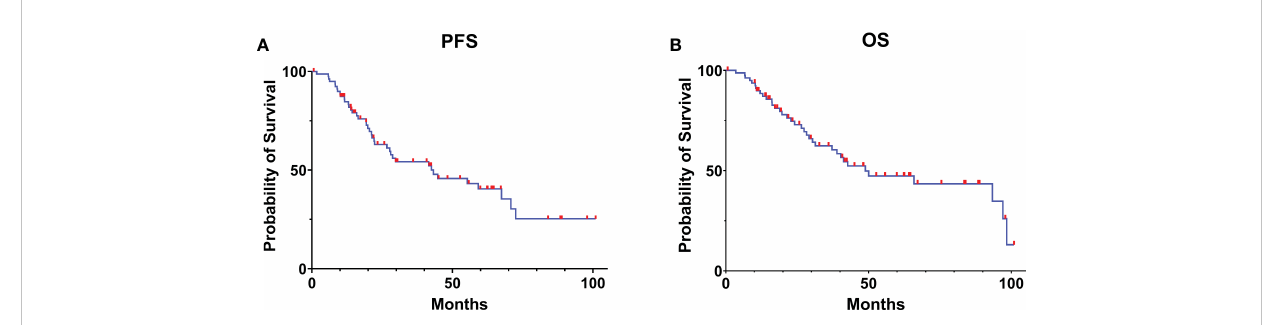
FIGURE 1 Kaplan-Meier curve estimates of progress-free survival (A) and overall survival (B) for the patients with glioma receiving awake brain mapping surgery in our cohort.